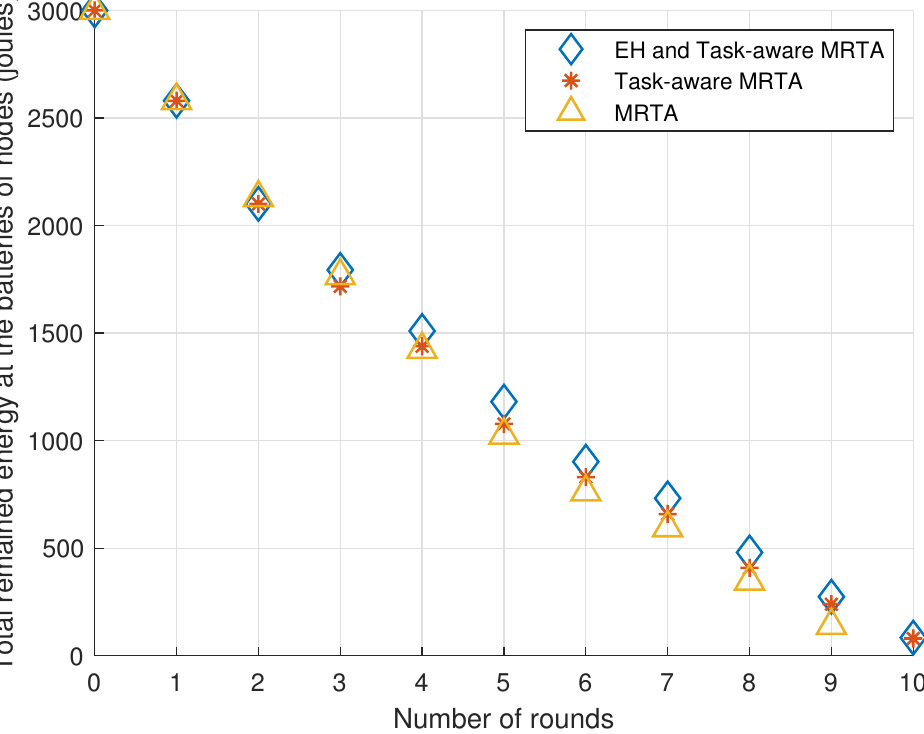
Figure 7. Total remaining energy in the batteries of the five Markov EH robot nodes versus the number of rounds under Markov EH processes.